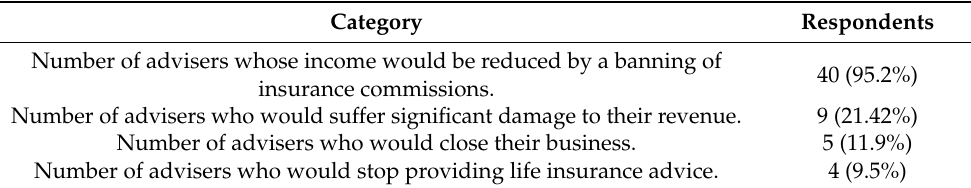
Table 3. Impact of banning of insurance commissions. Category Respondents Number of advisers whose income would be reduced by a banning of 40 (95.2%) insurance commissions. Number of advisers who would suffer significant damage to their revenue. Number of advisers who would close their business. Number of advisers who would stop providing life insurance